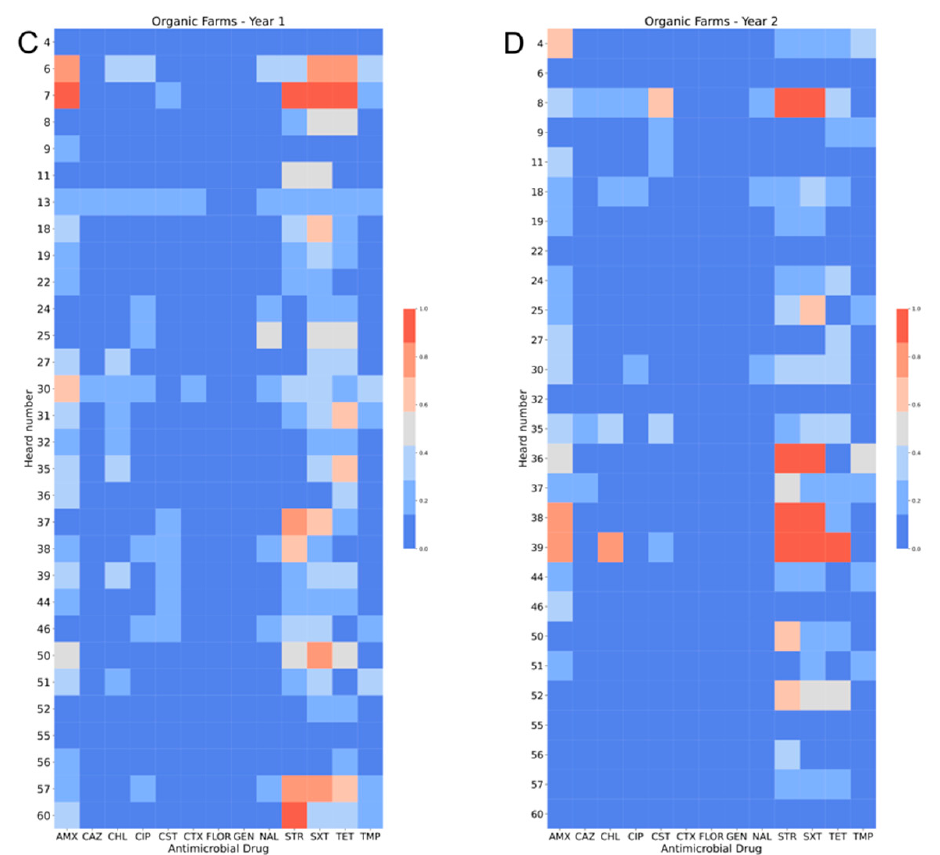
Figure 5. Heatmaps showing the patterns of resistant and susceptible Escherichia coli isolates from Swedish organic and conventional dairy herds sampled in two di ff erent time periods. ( A ) conventional herds1stsampling( B )conventionalherds2ndsampling( C )organicherds1stsampling( D )organicherds 2ndsampling. Colorscaleillustratesaveragevalueforeachherdandeachantimicrobialsubstancetested, where 1 = resistant and 0 = susceptible. AMX = ampicillin, CAZ = ceftazidime, CHL = chloramphenicol, CIP = ciprofloxacin, CST = colistin, CTX = cefotaxime, FLOR = florfenicol, GEN = gentamycin, NAL = nalidixic acid, STR = streptomycin, SXT = sulfamethoxazole, TET = tetracycline, and TMP =